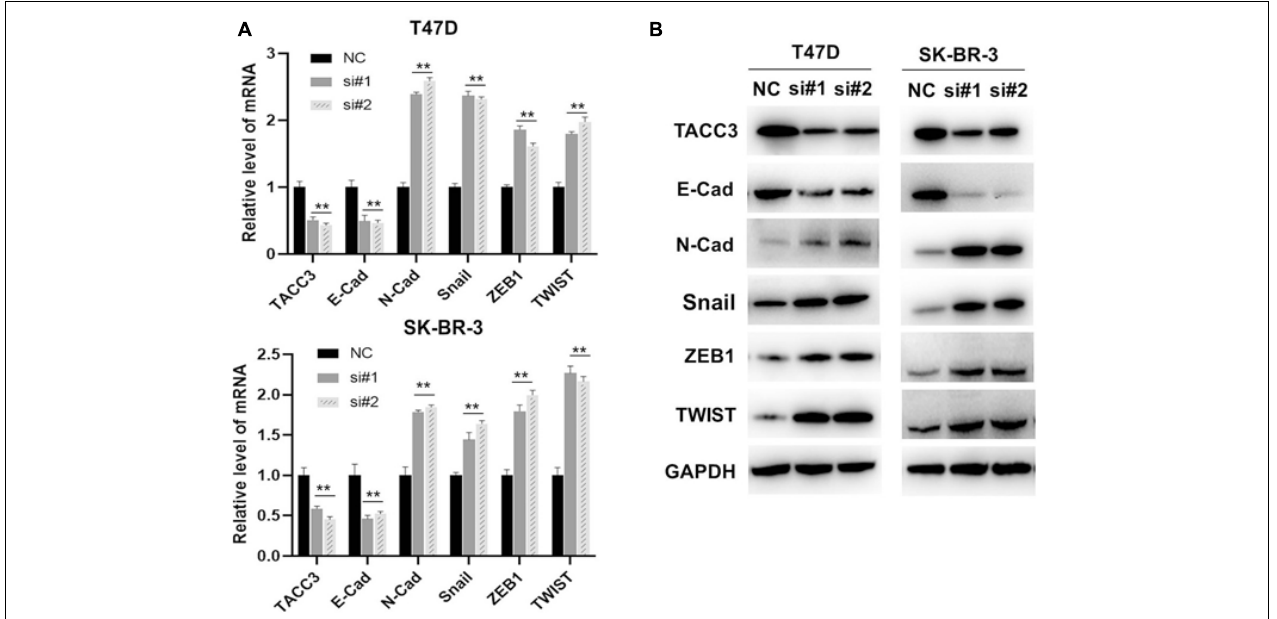
FIGURE 8 | TACC3 represses the epithelial-mesenchymal transition (EMT) through the Wnt/ β -catenin and Notch signaling pathways. (A) RT-PCR assay for assessing the expression levels of E-cadherin, N-cadherin, Snail, ZEB1, and TWIST following siTACC3-treatment. (B) Western blot analysis assay on the expression of EMT-related factors in siTACC3-treated cells. All assays were performed in biological triplicate. Data are shown as mean ± S.E.M. ***Compared with NC cells, p < 0.001; **compared with NC cells, p < 0.01; *compared with NC cells, p < 0.05. P -values are calculated by Student’s t